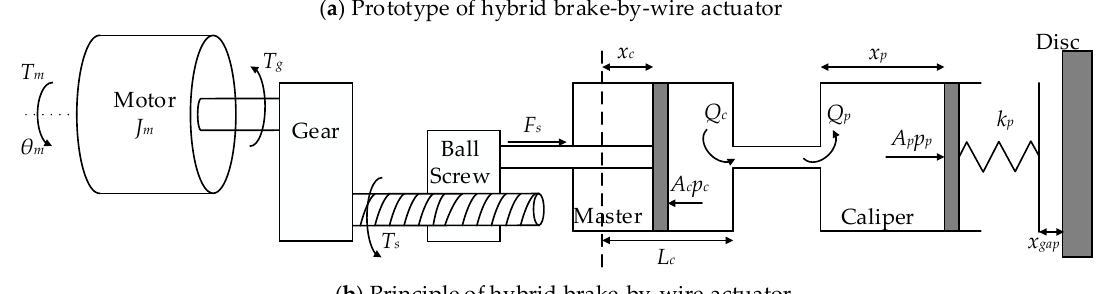
Figure 7. Hybrid brake-by-wire actuator.